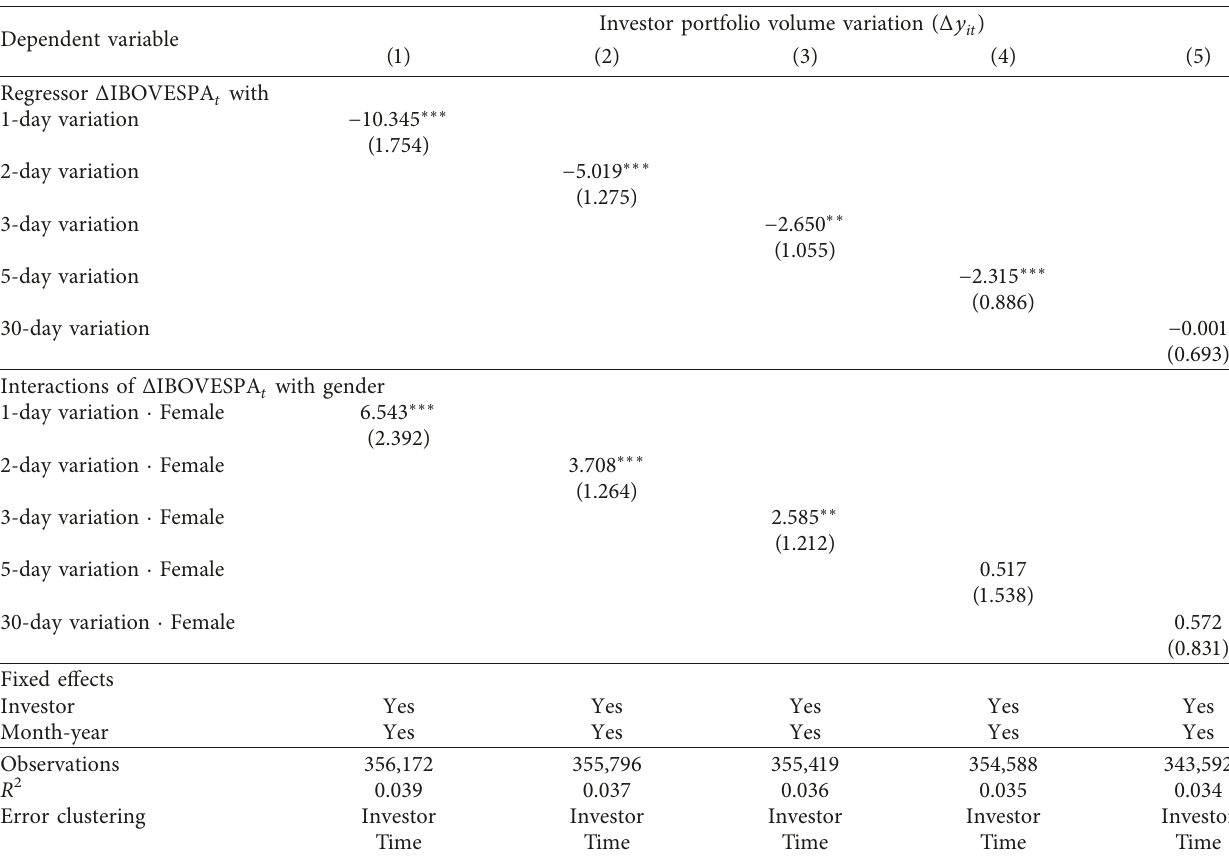
Table 3: Output from Regression (5). We ask whether female investors have different sensitiveness with respect to their investment portfolio to IBOVESPA index changes. We only use changes rather than past averages because the former has greater prediction power as reported by our feature selection procedure. The dependent variable is the variation of portfolio investment volume of investor i at time t in the Brazilian stock market from the beginning of 2016 to the end of 2018. Regressors are 1- (1), 2- (2), 3- (3), 5- (4), and 30-day (5) IBOVESPA index variations, as well as their interaction with the investor’s gender. The panel is on a daily frequency basis. Following Petersen [50], we